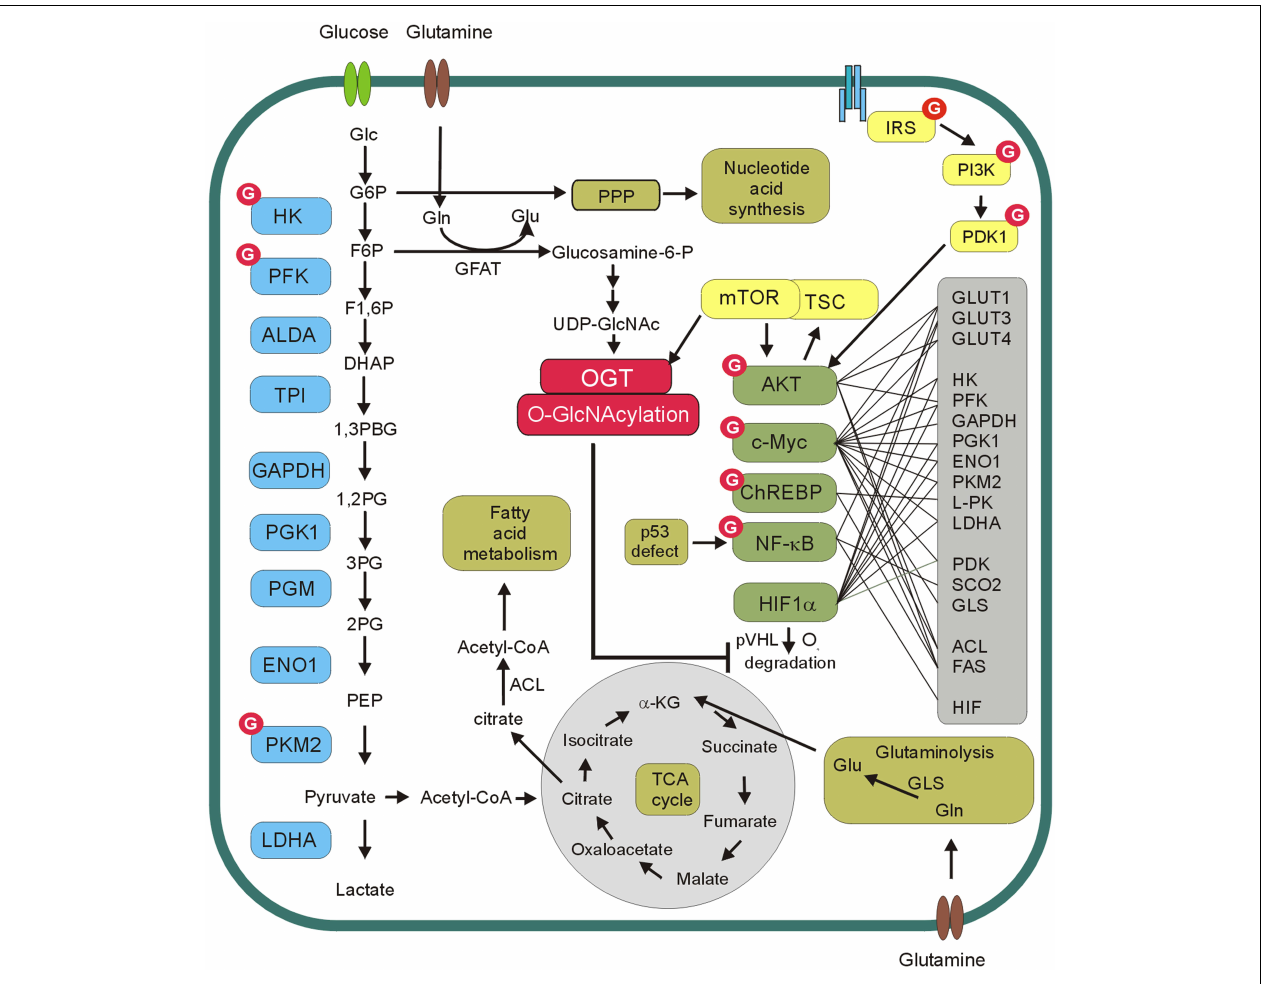
generated. OGT modifies and regulates several glycolytic enzymes, transcription factors as well as components of PI3K/Akt/mTOR pathway. Akt, c-Myc, ChREBP, NF-kB, and HIF-1 α reprogram cellular metabolism by direct or indirect regulation of expression of glucose transporters (GLUT1, GLUT3, GLUT4), glycolytic enzymes (HK, PFK, GAPDH, PGK1, ENO1, PKM2, L-PK, LDHA), pyruvate dehydrogenase kinase (PDK), glutaminase (GLS), cytochrome c oxidase 2 (SCO2), fatty acid synthase (FAS), ATP citrate lyase